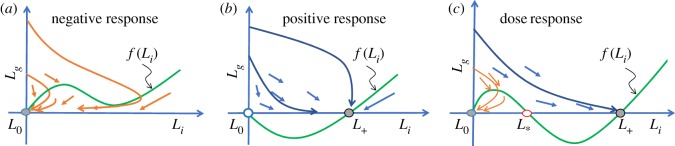
Illustration of steady states and vector field governing the solutions of model (3.1). The Li-nullcline is represented by f(Li) and the Li-axis represents the Lg-nullcline. The vector field demonstrates the possible course of direction of the model solutions as they start from an initial value (dose) on the Lg-axis. The filled circles represent stable steady states while open circles represent unstable steady state. Three distinct scenarios arise from threshold conditions. (a) r< 4αKβ/(1+αK)2: solutions always approach the 0 steady state (L0), indicating bacterial extinction independent of initial conditions; (b) β<r: solutions always approach the positive steady state (L+), showing bacterial persistence independent of initial values; (c) 4αKβ/(1+αK)2<r<β: solutions can approach either L0 or L+ depending on the initial value (dose), creating a scenario that can generate dose–responses.